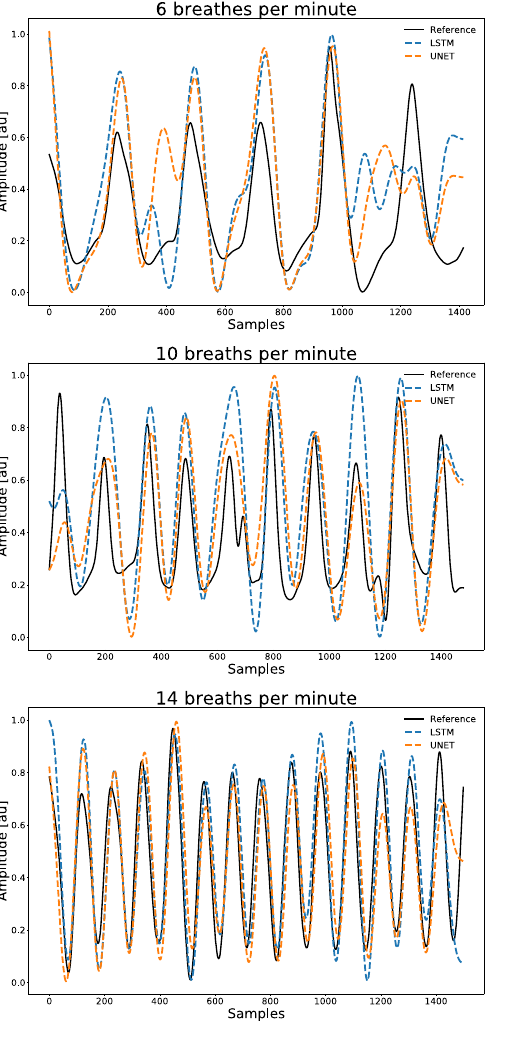
Figure 3. Example window for 6, 8, 10, 12, and 14 breaths per minute is shown for Participant 1. Training Time The LSTM trained slower: 18 (3) minutes vs. 11 (4) mins for the U-Net. Both architectures took an input of 320 samples (~13 seconds) and predicted a single sample from the respiratory waveform. Approximately 13 seconds of input data were selected based on previous parameter search